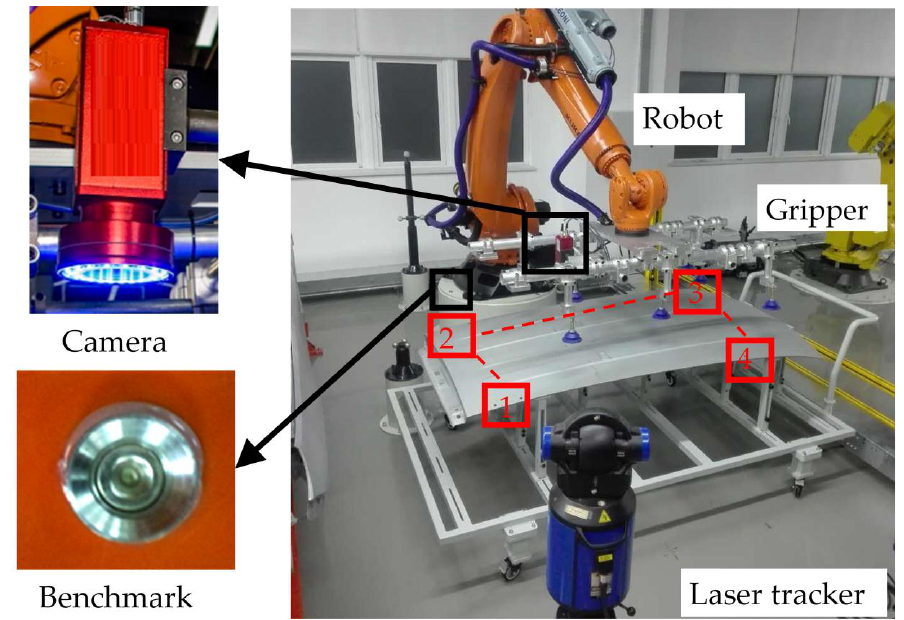
Figure 6. Experimental setup for robot intelligent grasping